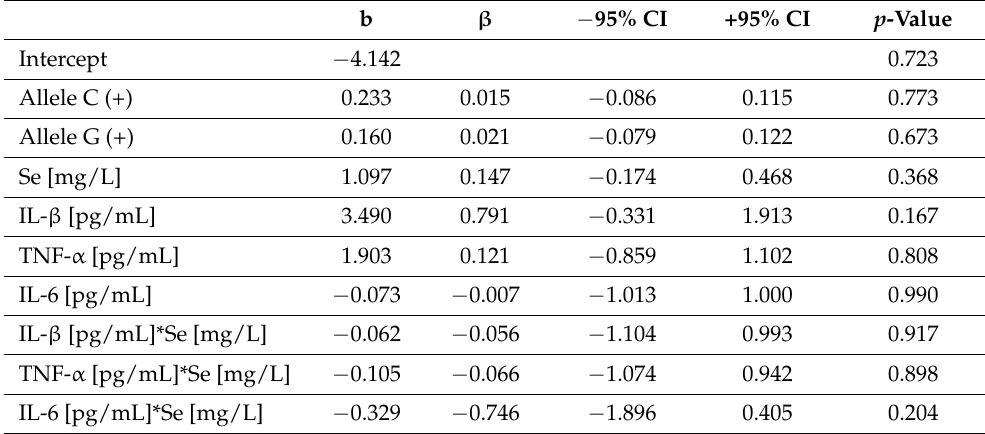
Table 15. Model I with moderation by